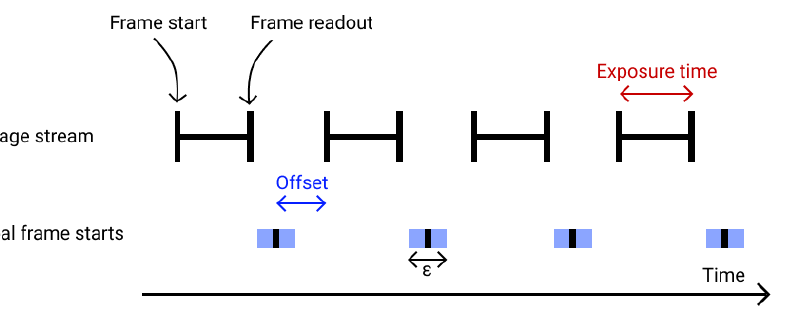
Figure 10. Phase alignment problem setup (the figure is inspired by the scheme from Reference [7]). Application aligns frame capture starts within requested tolerance (cid:101)